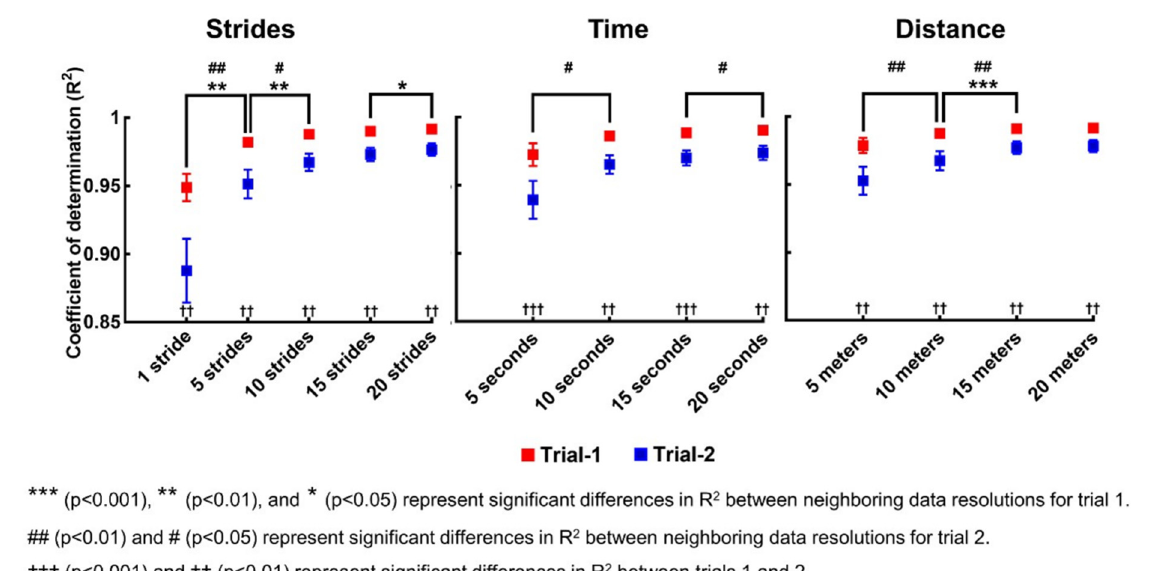
Figure 4. The goodness of fit of the curve fitting model of the VGRF estimation error. The figures from left to right are the means and standard error bars of the coefficient of determination ( R 2 ) for 20 participants when fitting the error ( ∆ I ) with respect to the stride number (strides), the operation time of the treadmill (time), and the distance traveled by the treadmill belt (distance), respectively, for the two trials. We assessed the model’s goodness of fit for the curve fitting with respect to every single stride, every 5, 10, 15, and 20 strides. Similarly, we assessed model’s goodness of fit after downsampling ∆ I by averaging it over 5, 10, 15, and 20 s; and 5, 10, 15, and 20 m for time and distance, respectively. Generally, downsampling the data increased the mean R 2 of 20 participants. The mean R 2 of 20 participants for the first trial was larger than the second trial.